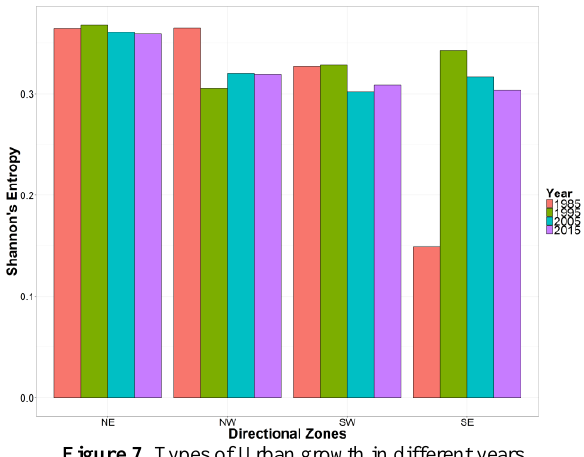
Figure 7. Types of Urban growth in different